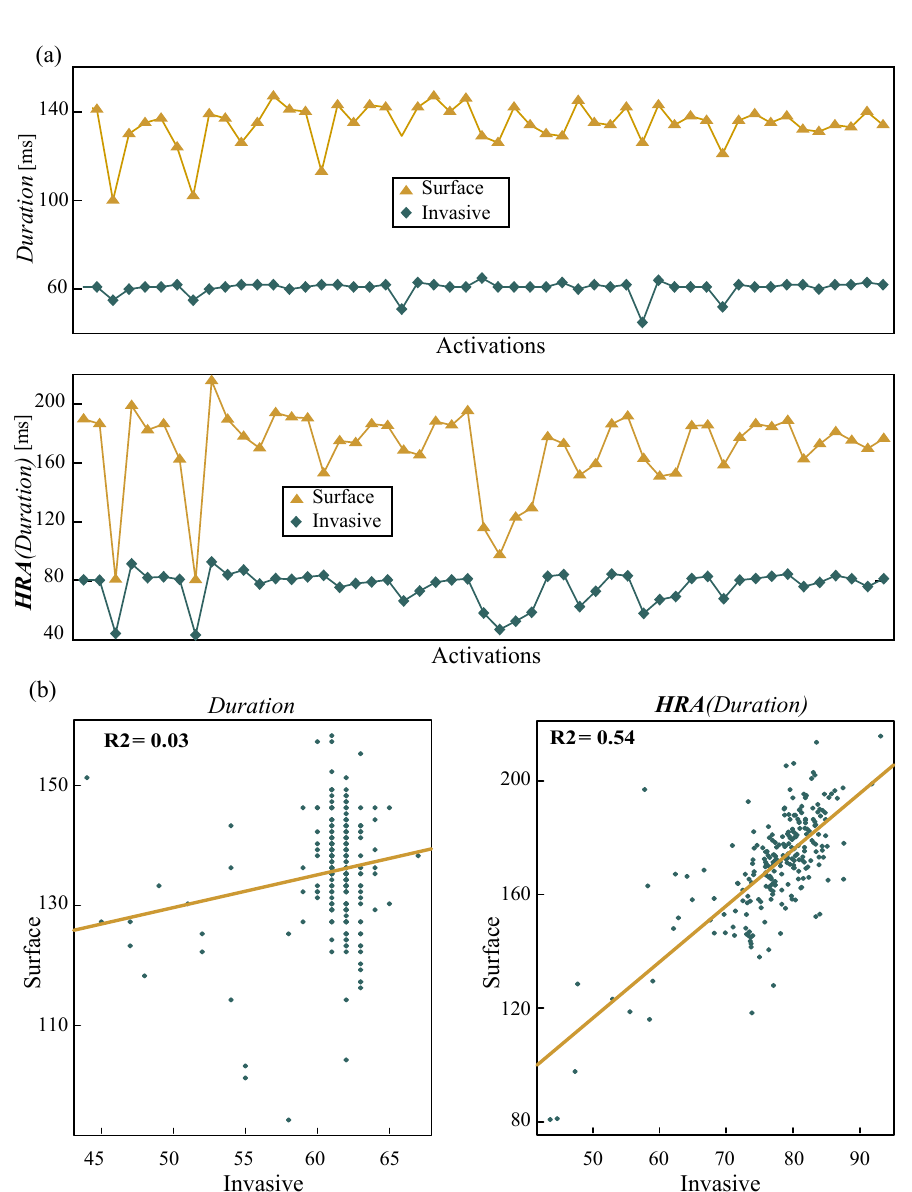
Figure 2. Example of how HRA affects the correlation of the computed features. ( a ) Time instance of 50 activations for the correlation of Duration , unprocessed ( top ) and after HRA ( bottom ). ( b ) Linear regression of the same recording before ( left ) and after ( right ) HRA. Linear correlation increased from R 2 = 0.03 to R 2 = 0.54. HRA: heart-rate